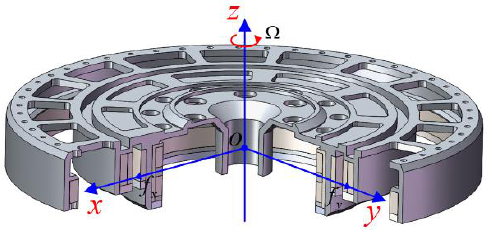
Figure 2. Force analysis and coordinate system of the MLRW.